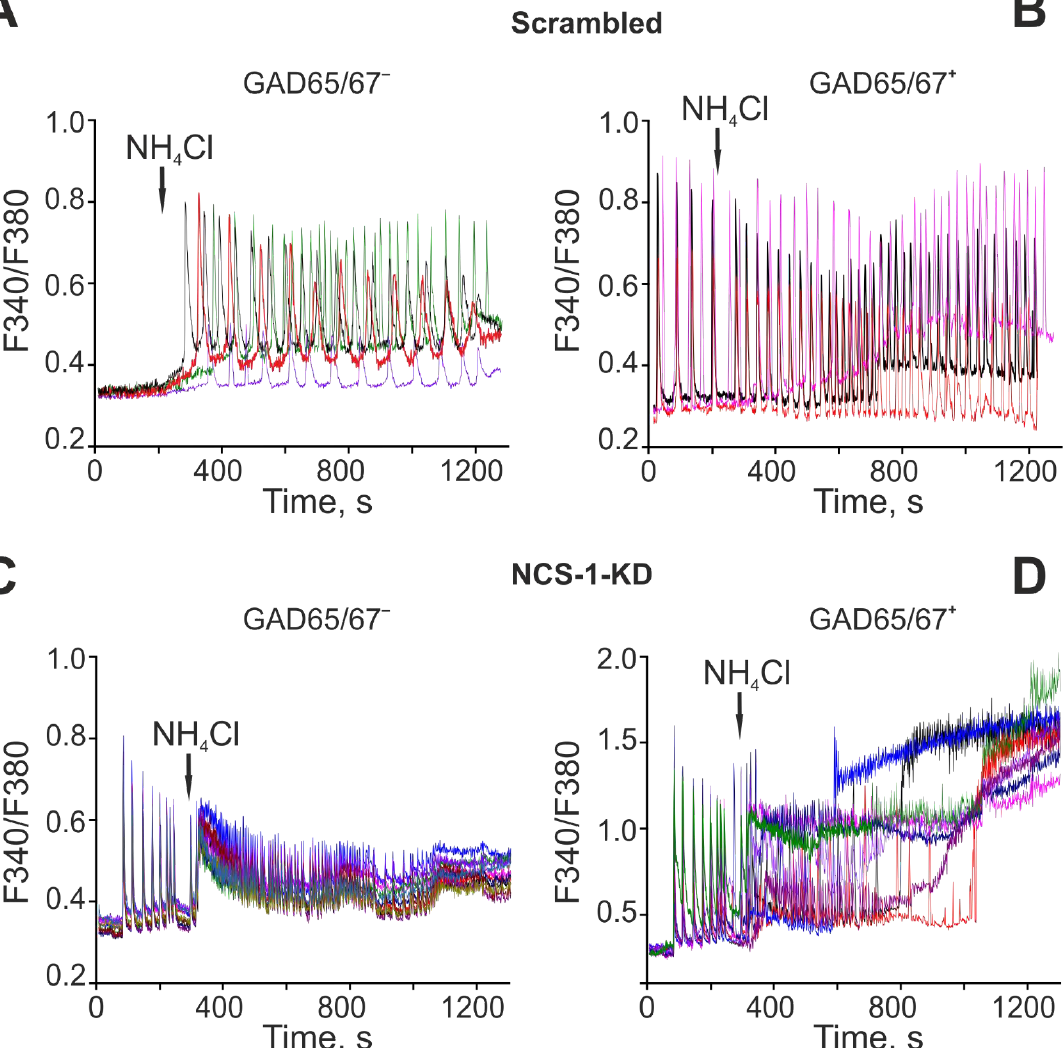
Figure 7. The role of NCS-1 in hyperexcitation of non-GABAergic (GAD65/67 – ) and GABAergic neurons of the cerebral cortex under the action of hyperammonemia. NCS-1 contributions to NH 4 Cl- induced global [Ca 2+ ] i increase in GABAergic neurons. ( A , B ) Ca 2+ -signals of control (Scra) non- GABAergic (GAD65/67 – ) ( A ) and GAMBergic ( B ) neurons of the cerebral cortex upon application of 8 mM NH 4 Cl. ( C , D ) Ca 2+ -signals of non-GABAergic ( C ) and GABAergic ( D ) neurons of the cerebral cortex after NCS-1-KD upon application of 8 mM NH 4 Cl. Typical Ca 2+ -signals of neurons in one experiment are shown.